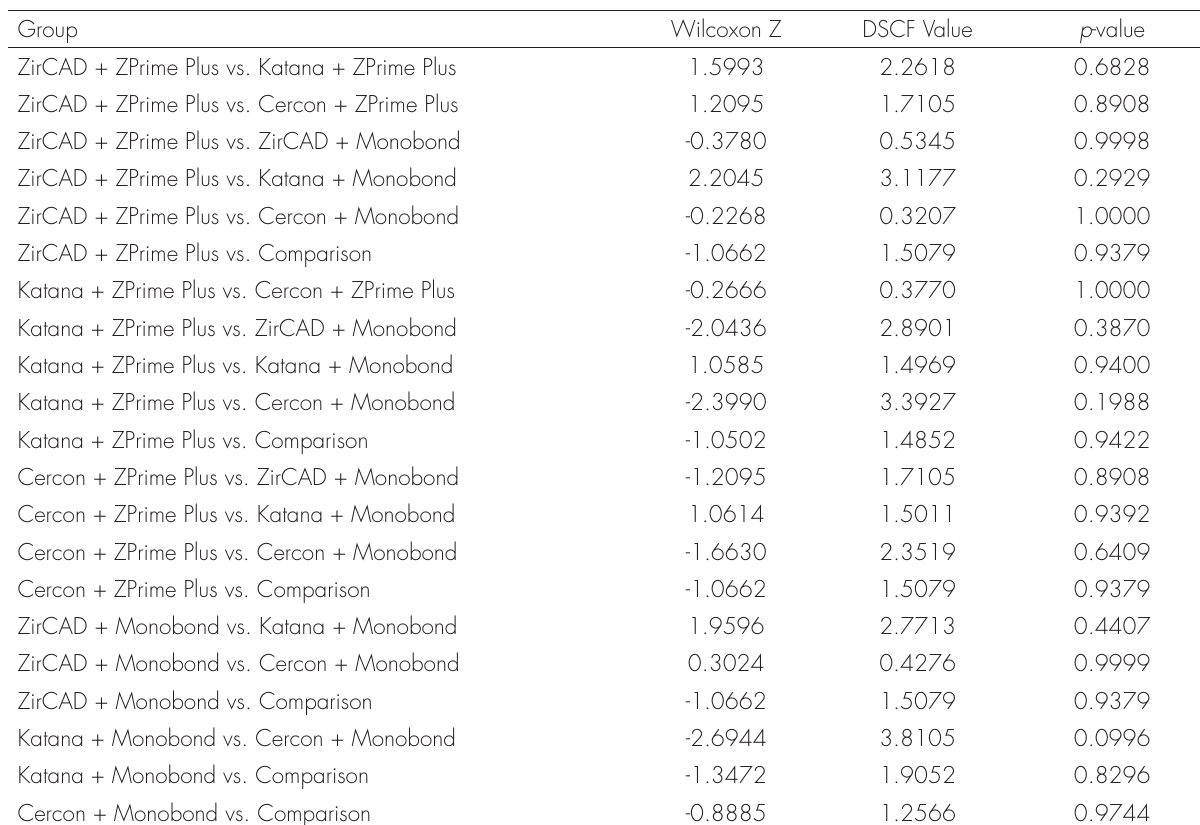
Table IV. Pairwise two-sided multiple comparison